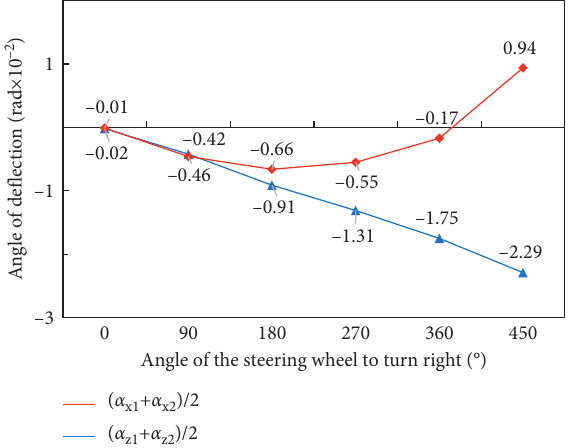
Figure 13: Deflection angles under different steering wheel